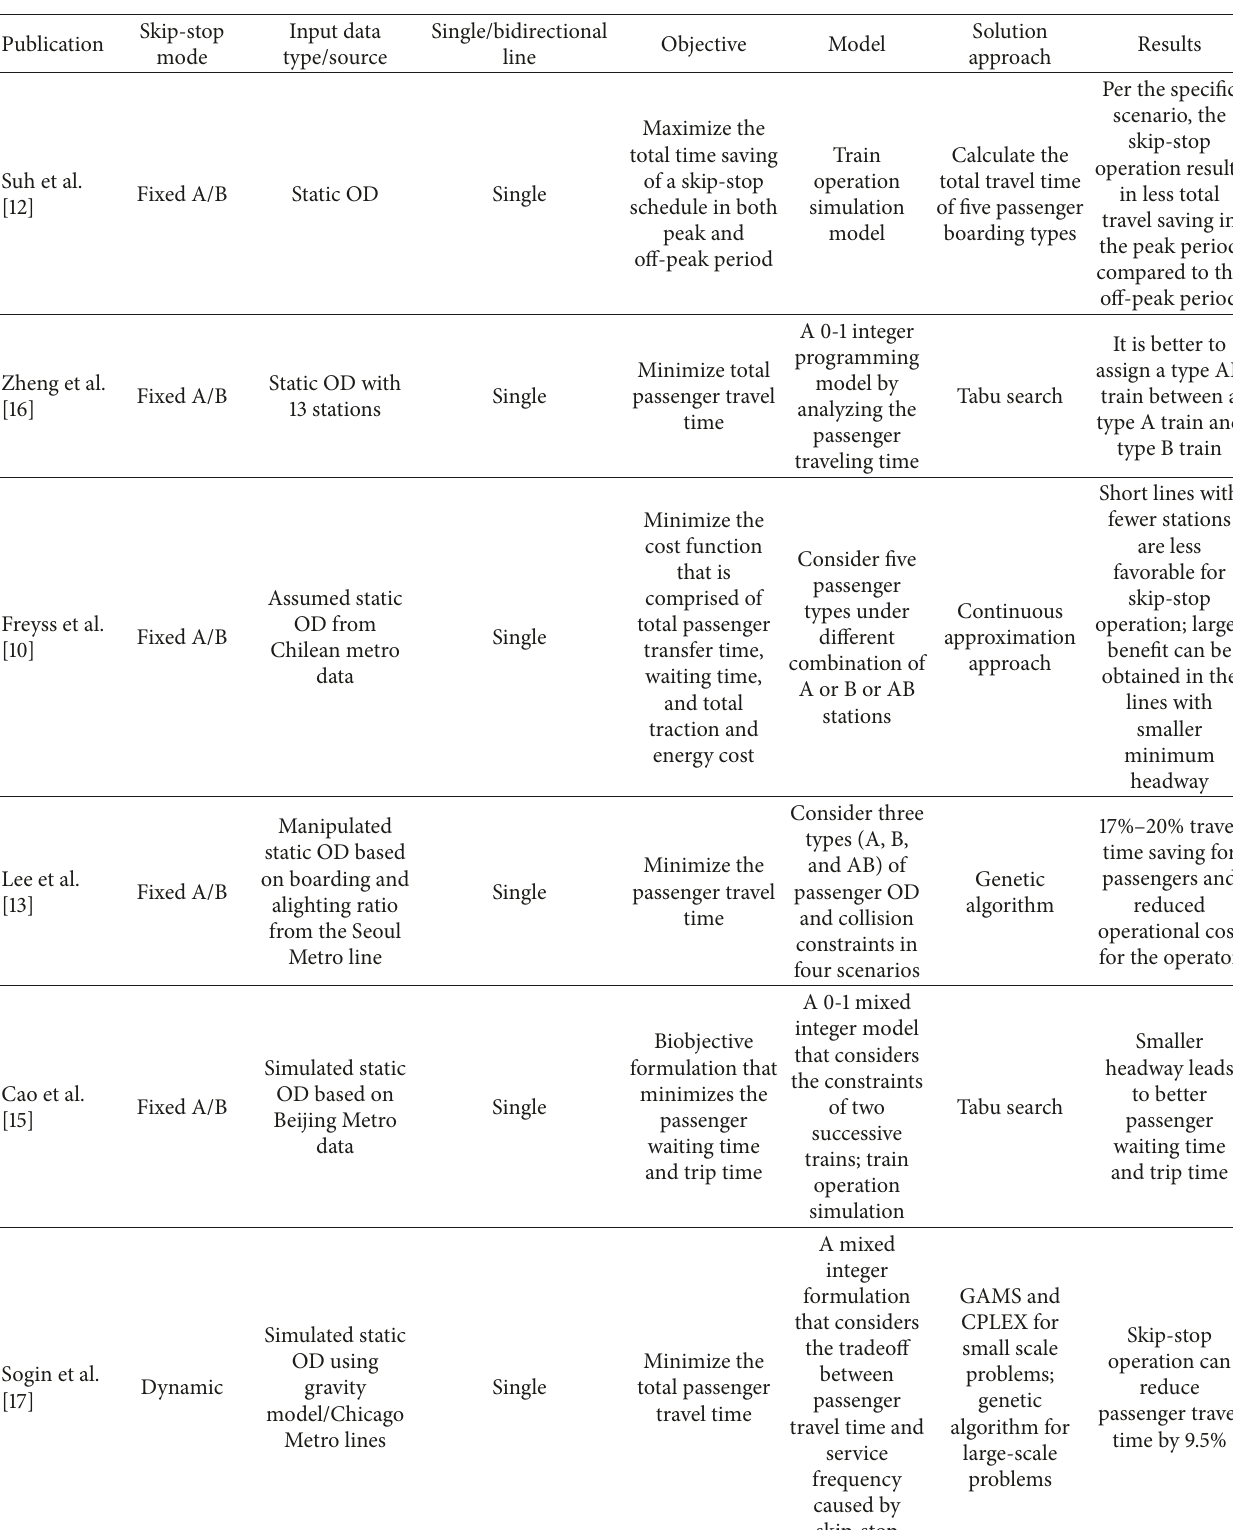
Table 1: Existing skip-stop schemes for metro